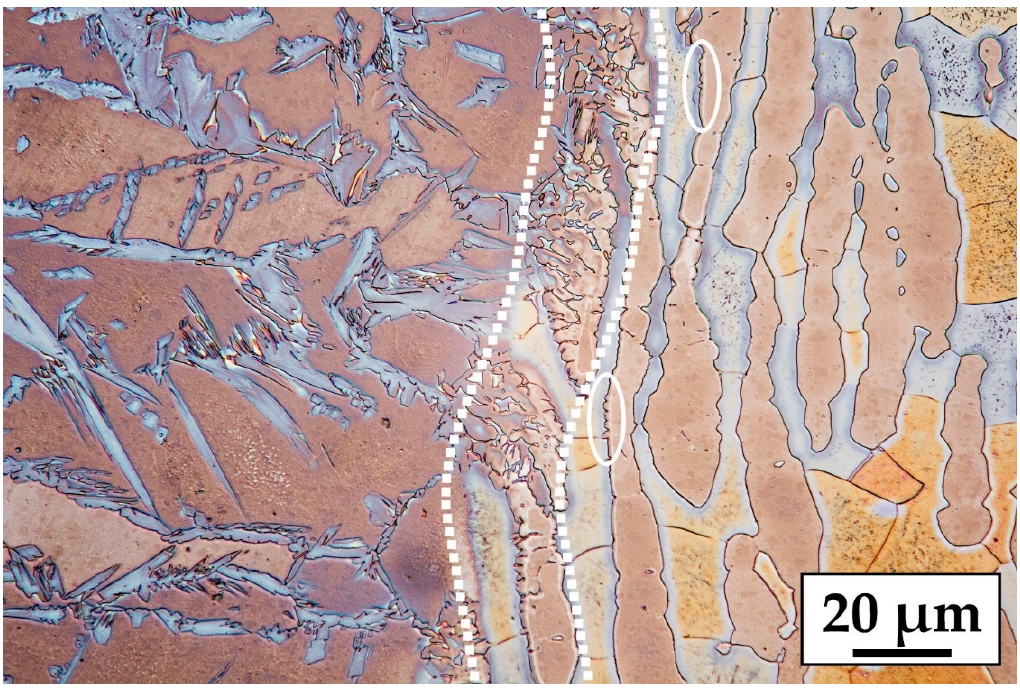
Figure 3. Heat Affected Zone (HAZ) of the sample deformed at 29.6%.